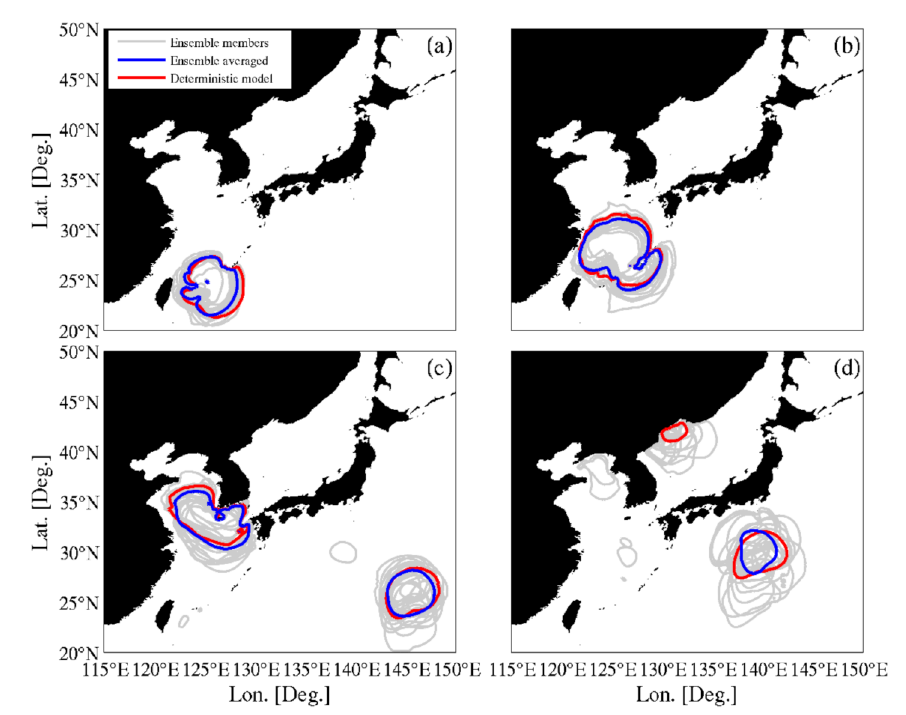
Figure 5. Comparison of the results of each ensemble model member with a significant wave height of 5 m, the result of the ensemble mean, and the result of a deterministic forecast model (forecast lead times of ( a ) +00 h, ( b ) +24 h, ( c ) +48 h, and ( d ) +72